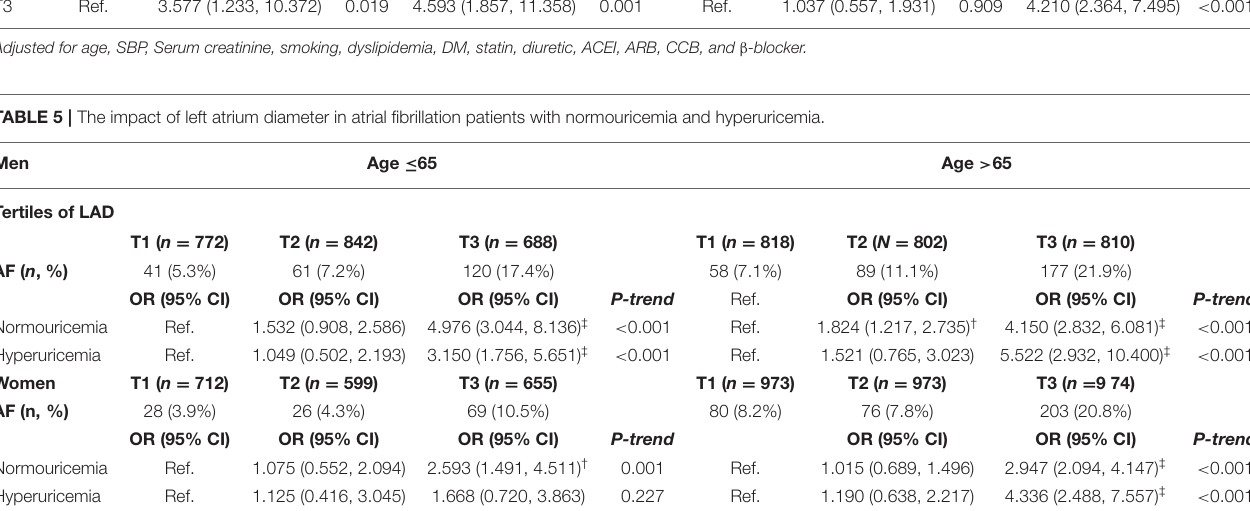
Tertile of LAD in women ( N = 4,868)